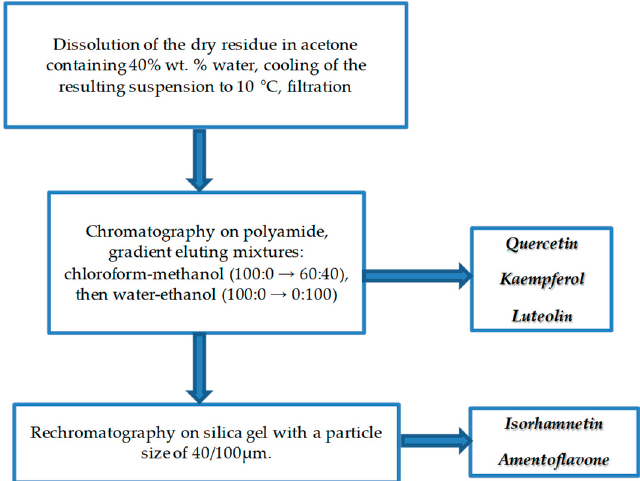
Figure 8. The developed scheme of purification of biologically active substances obtained from the extract of Ginkgo biloba .